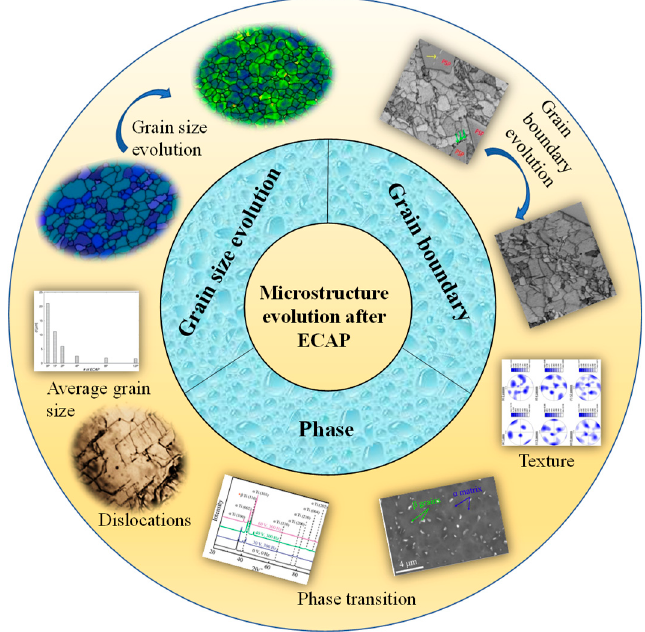
Figure 2. Overview map [25–31]. Reproduced with permission from Elsevier B.V. Copyright 2014. Reproduced with permission from Elsevier Editor Ltd. Reproduced with permission from Springer Nature. Reproduced with permission from MDPI. Reproduced with permission from Elsevier B.V. Reproduced with permission from Elsevier Ltd.